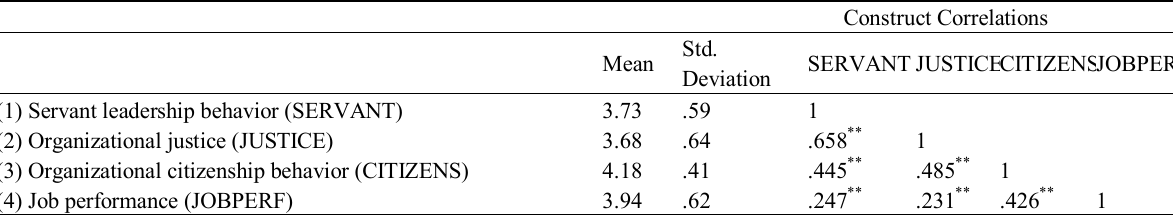
Table 2.Descriptive statistics for the scales and construct